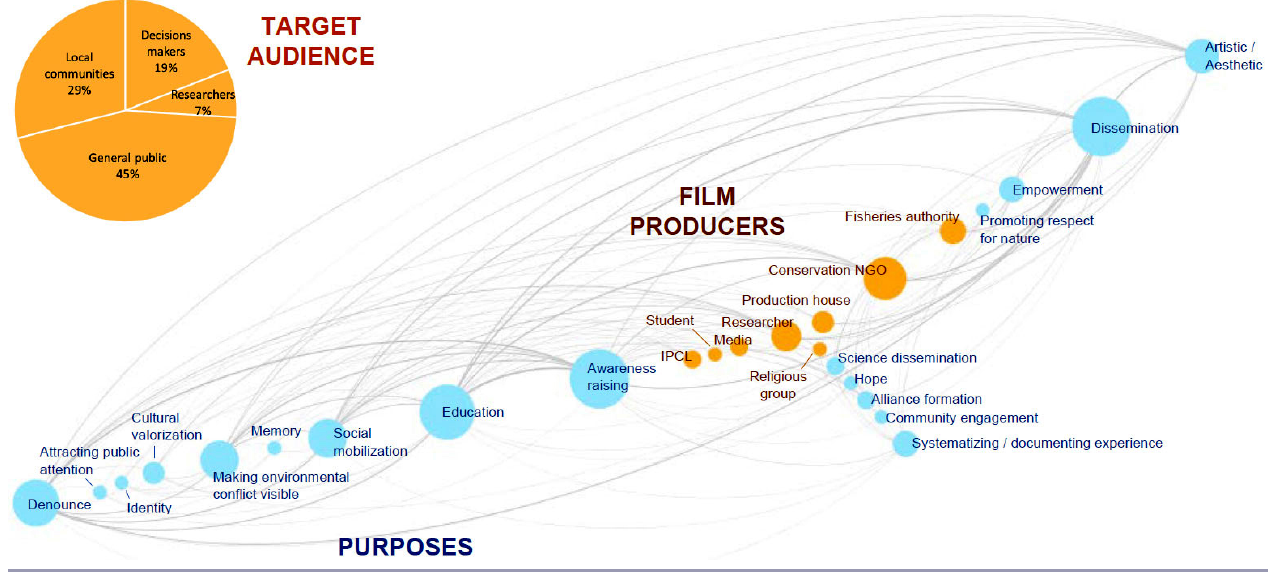
Fig. 3 . Network of purposes and film producers. Note: Radial axis layout, grouping nodes by modularity class. Data on target audience, added manually. IPCL, indigenous people and local communities.